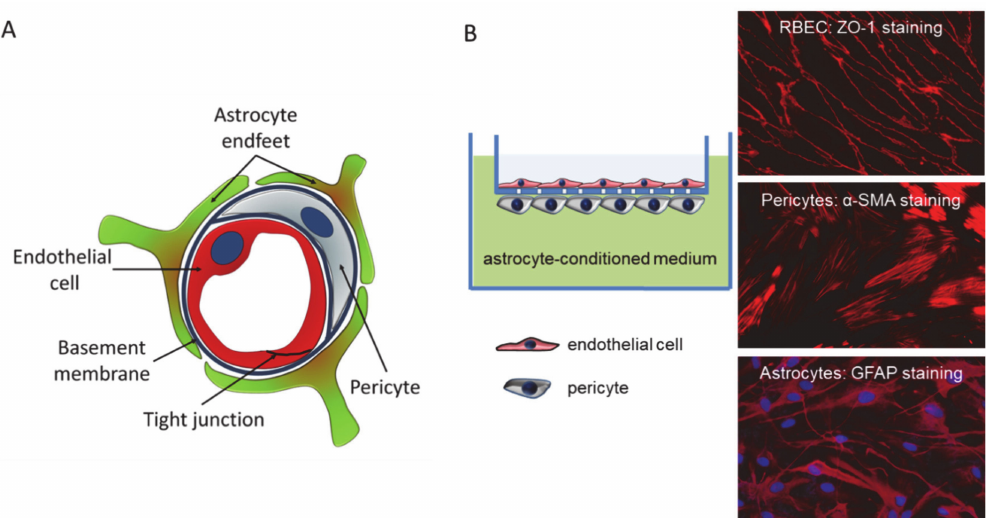
Figure 4. The in vitro BBB model. ( A ) Schematic representation of the cross-section of a brain capillary, showing the cellular composition. ( B ) The in vitro BBB model consists of cerebral endothelial cells cultured on filter inserts having pericytes on the bottom surface. Filters containing endothelial cells and pericytes are emerged in a well containing astrocyte-conditioned media. Right panels show representative immunofluorescence staining of respective cellular